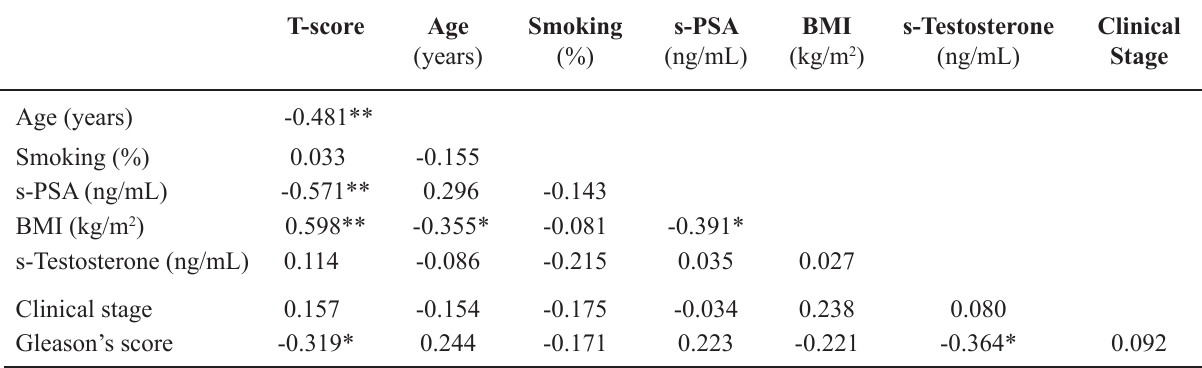
Table 4 – The factors associated with bone loss in Group I (prostate cancer group).